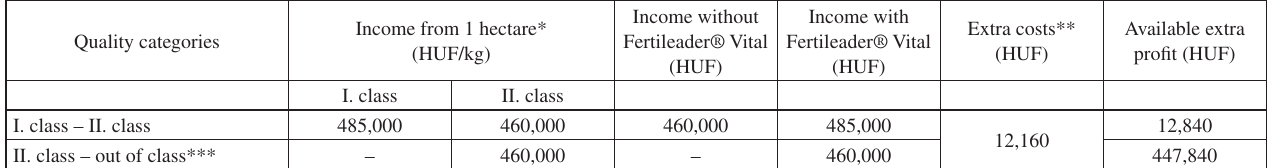
Table 2. Economic benefi t (net prices) of using Fertileader® Vital (calculated for 1